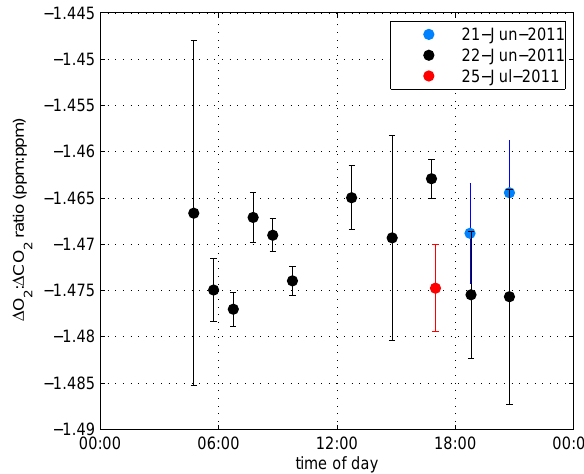
Fig. 8. 1 O 2 : 1 CO 2 ratios for groups of exit-entrance flasks sam- pled in parallel, shown against time of day. Different colours indi- cate different sampling dates. The negative ratios are due to the fact that O 2 is consumed while CO 2 is